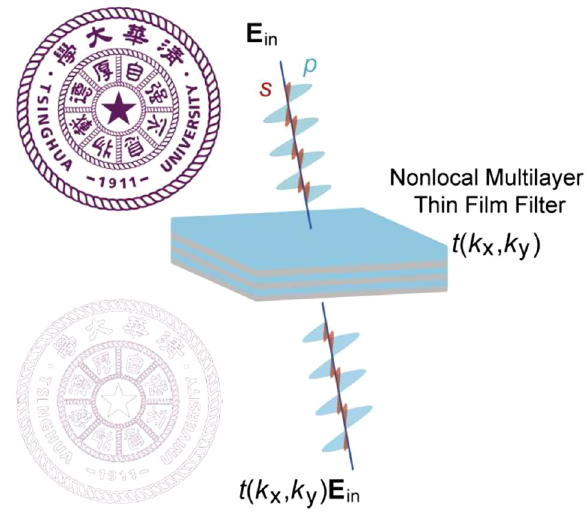
Figure1: Schematicof usingatransmissivemultilayerthinfilmwith a nonlocal optical response to directly perform 2D image differentiation with arbitrary polarization of the incident